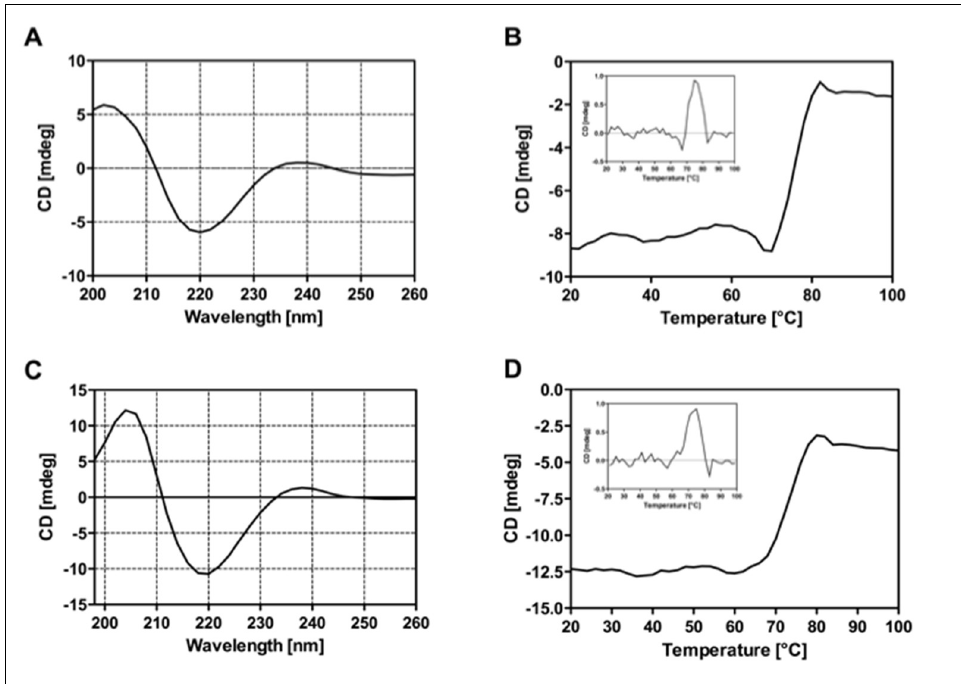
Figure 3. Panel of CD analyses. Far-UV spectra of Ritux Fab2 ( A ) and Ritux Fab ( C ) recorded at the con- centration of 4 µM at 20 °C. Denaturation curves were collected between 20 °C and 95 °C monitoring the CD signal at 218 nm. Ritux Fab 2 ( B ) and Ritux Fab ( D